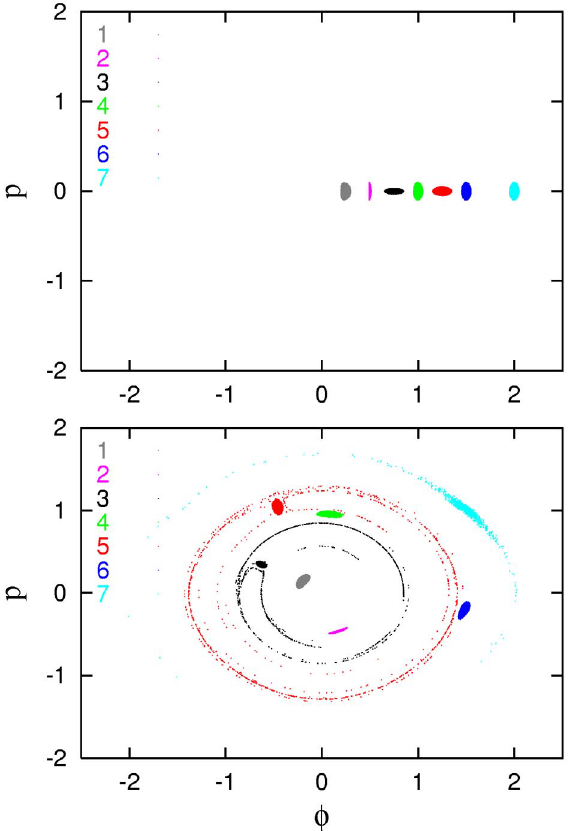
FIG. 15. (Color) Simulations using update equations (37) and (38) for isolated solitons. The initial states (top panel) are centered on p (cid:1) 0 and are indexed with increasing values of (cid:3) . The initial values of a , b , A , and ‘ obey Eq. (32), with a 0 slight modification for curvature. In each simulation all the test particles had the same charge. Plots of the final phase space are shown on the bottom. Simulation 2 was run for 1000 synchro- tron oscillations while the others ran for 100 synchrotron oscillations.